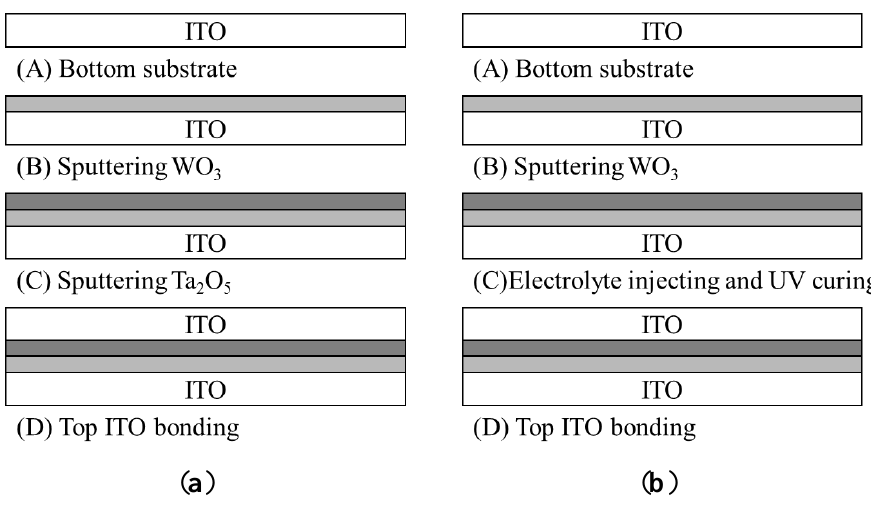
/Ta O /ITO and 3 2 5